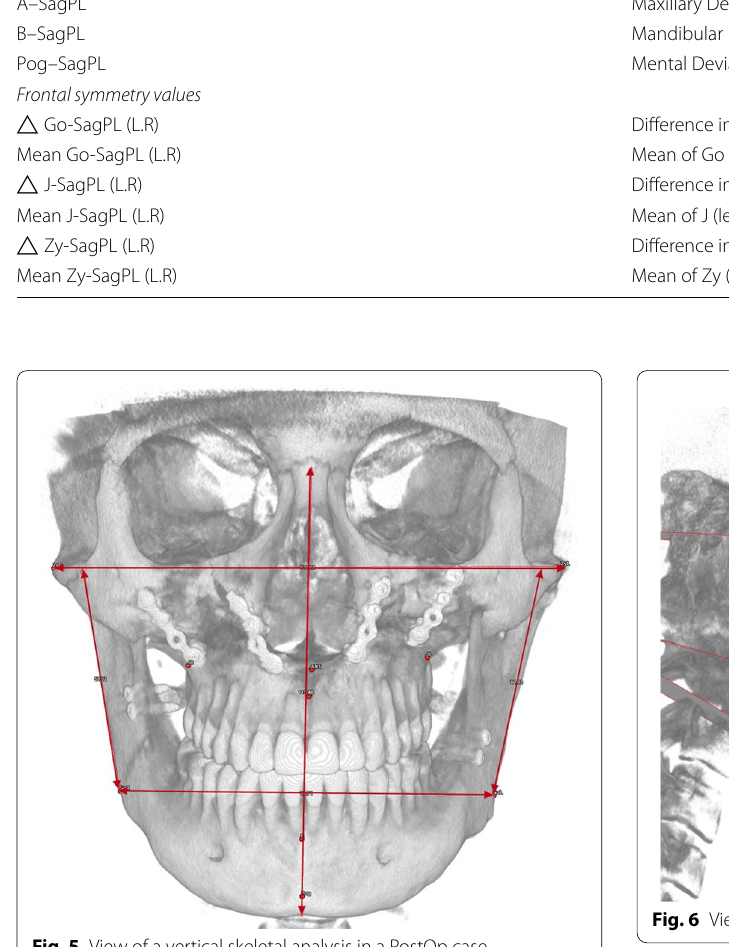
Fig. 5 View of a vertical skeletal analysis in a PostOp case